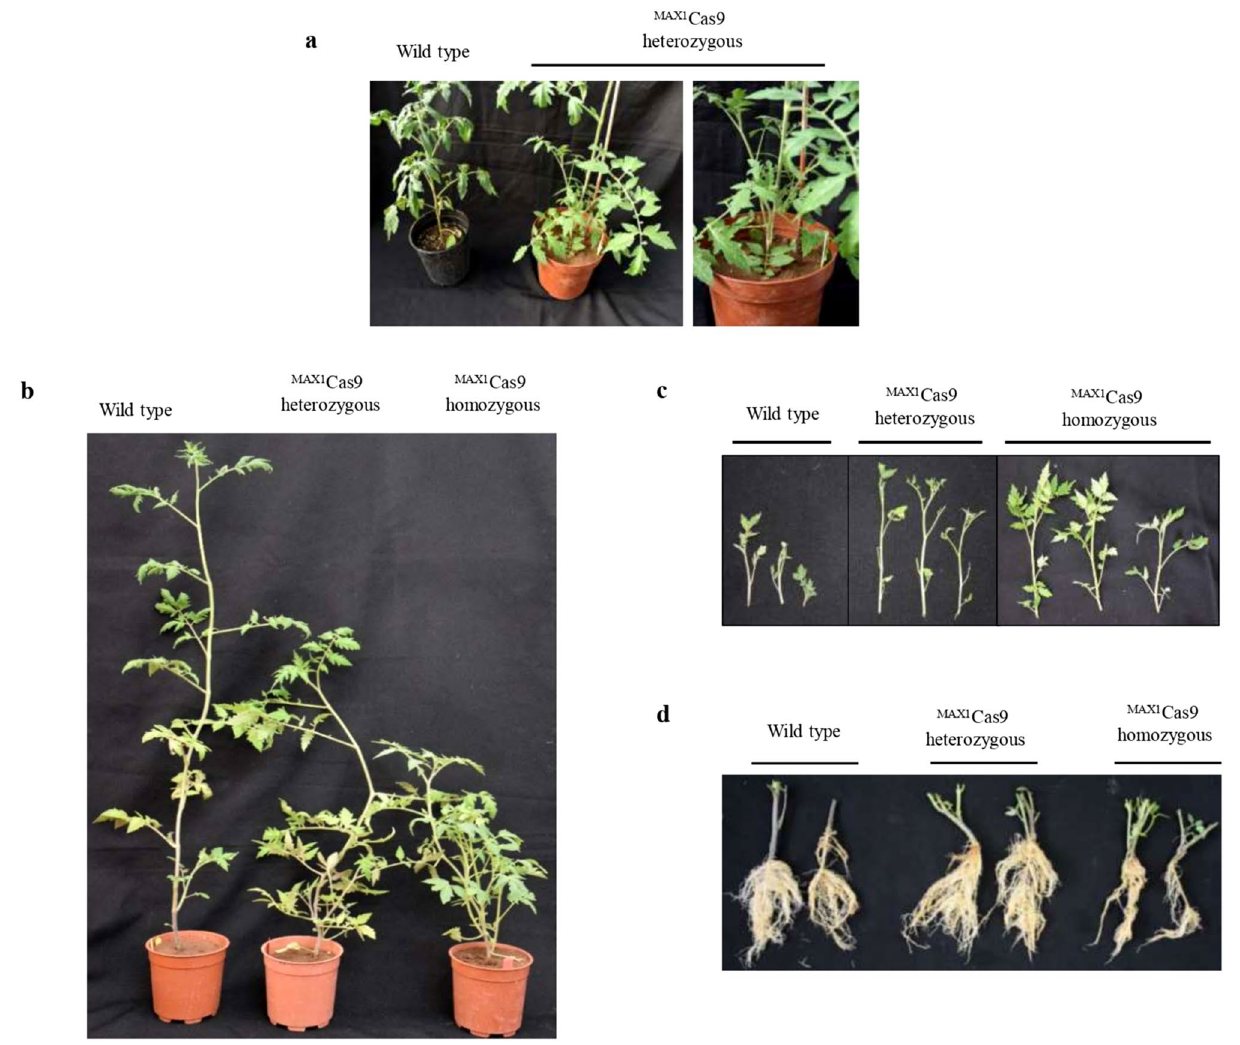
Figure 3. Morphological phenotype associated with MAX1 edited tomato lines. ( a ) MAX1-Cas9 edited T 0 heterozygous plant showing more growth of axillary buds as compare to wild type. ( b ) T 1 heterozygous plant showing mild change in phenotype. Wild type plants with normal vegetative growth; MAX1-Cas9 edited T 1 heterozygous and homozygous T 1 line ( c, d ) Comparison of length of axillary branches & root morphology in the wild type and Cas9